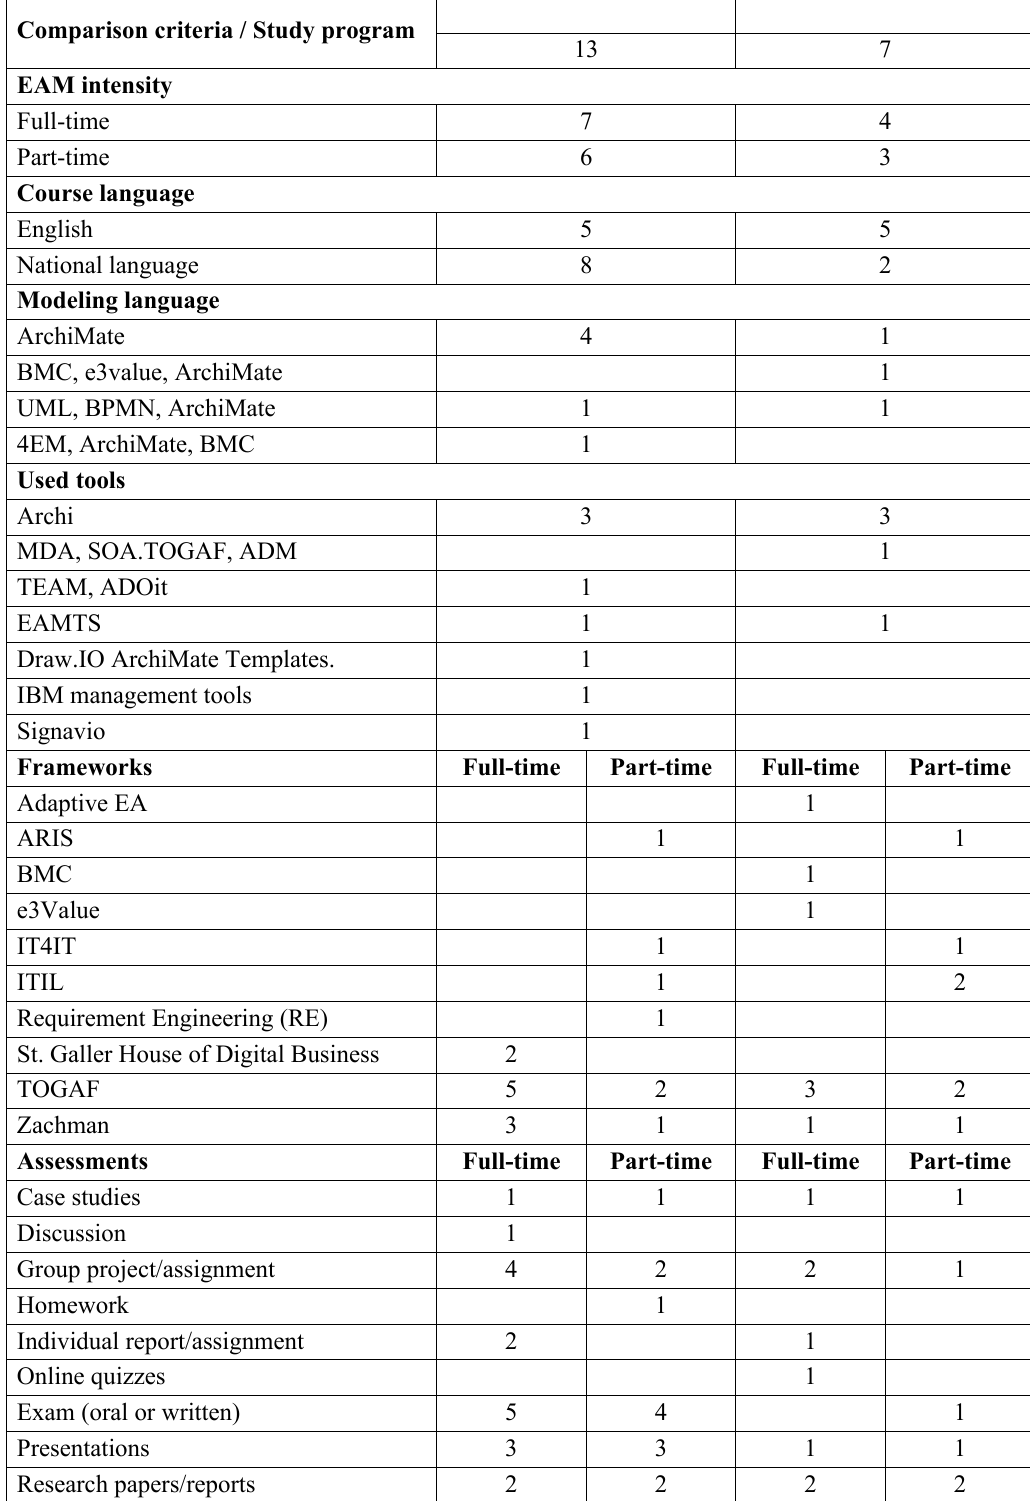
Comparison criteria / Study program